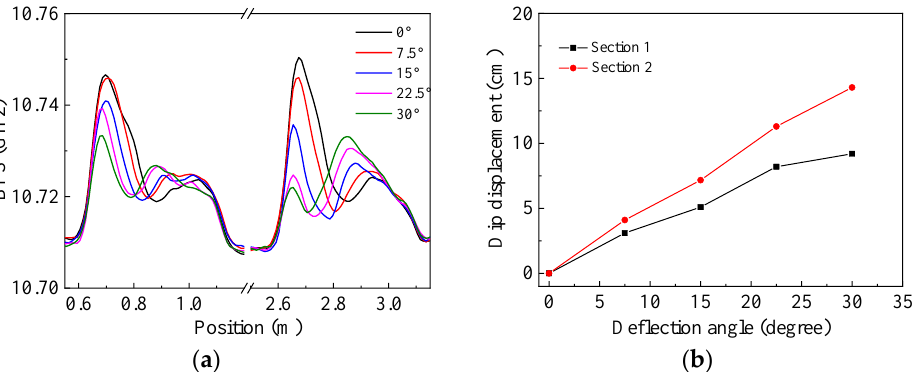
Figure 8. Measurement results of airflow direction: ( a ) BFS distributions of the sensing fiber at different deflection angles of the airflow; ( b ) Dip displacement vs. deflection angle for fiber sections 1 (black) and 2 (red), respectively.